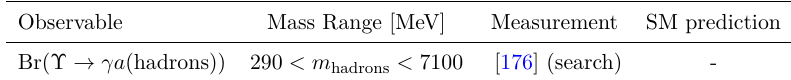
Table 7 . Observables with a tau pair in the final state. Bounds are at 90% CL.